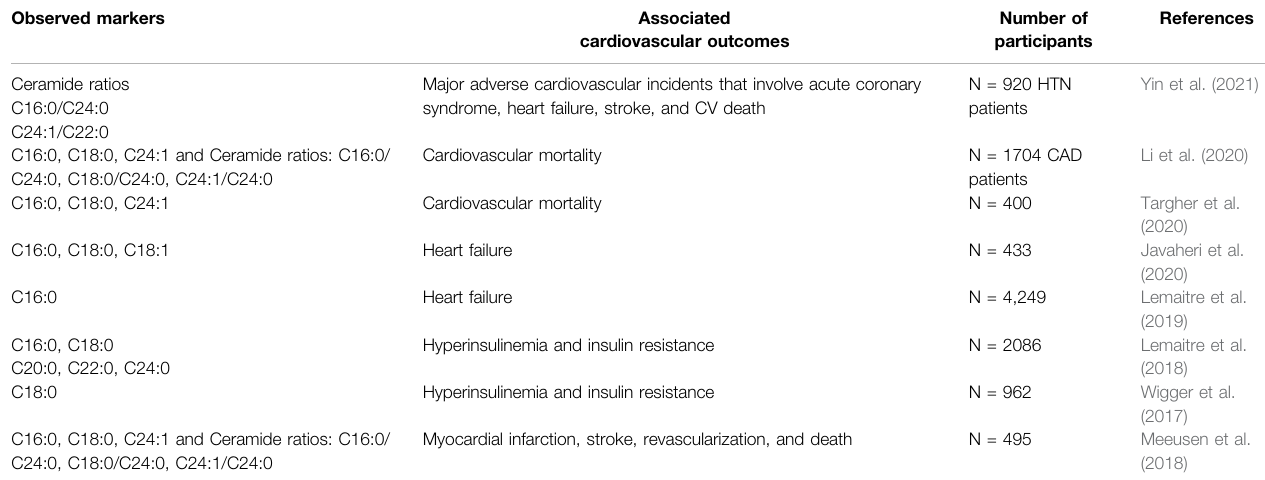
TABLE 2 | Summary of ceramides impacts on cardiovascular outcomes in humans. Observed markers